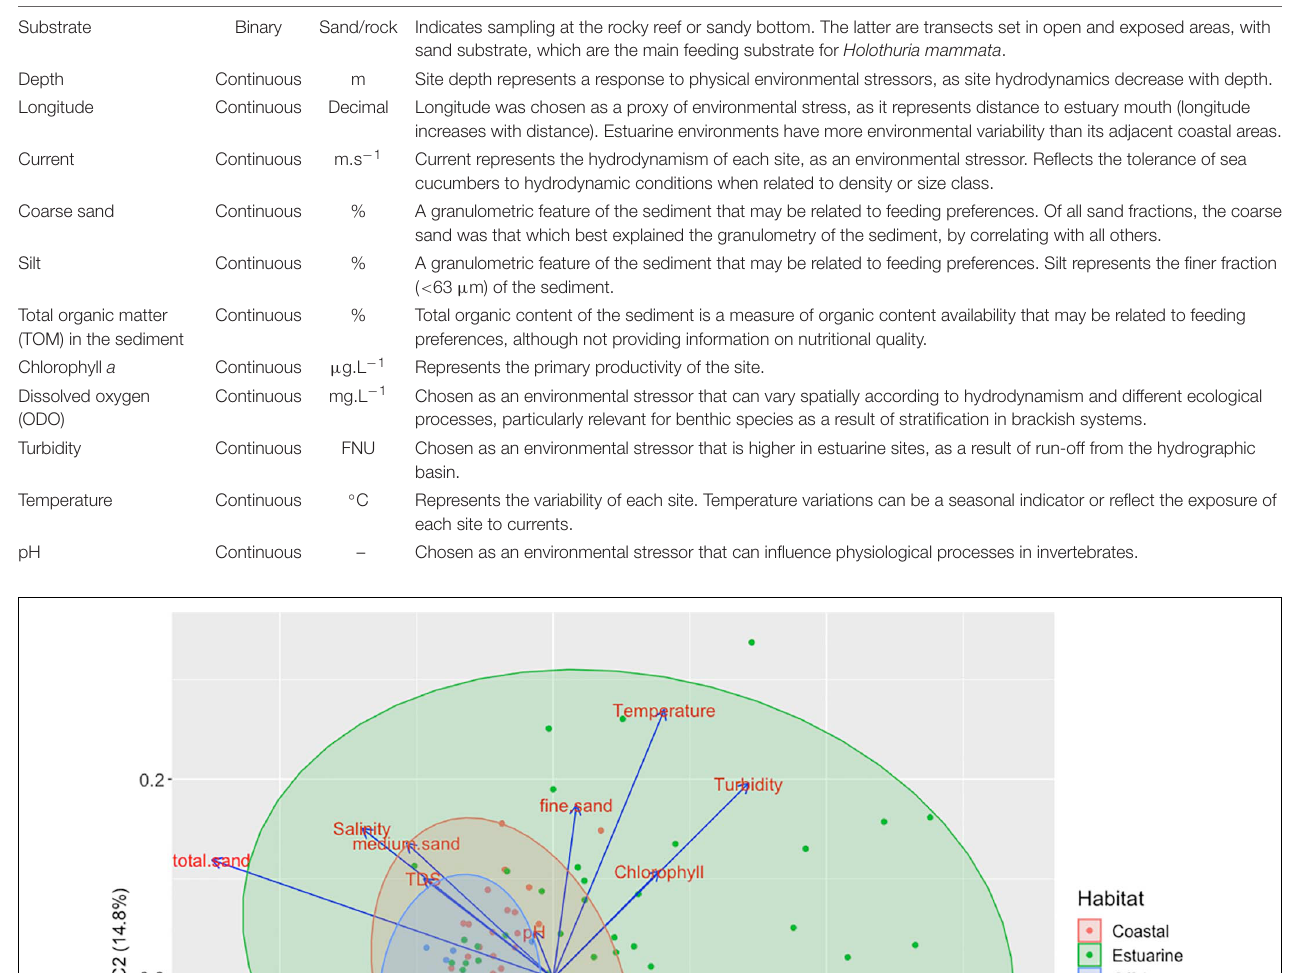
dependent make a poor predictor for distribution patterns. Thus, other variables were chosen to represent a proximity to the estuary (e.g., longitude, turbidity, and ODO). Besides, longitude is not influenced by tidal regimes and salinity is, which, in turn,